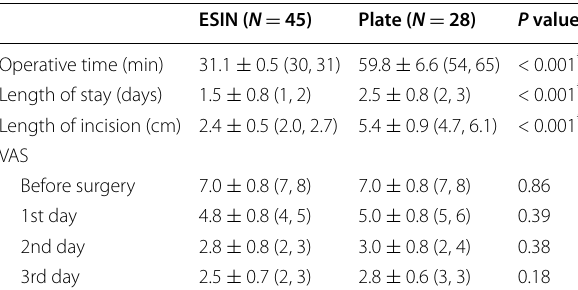
Table 2 Perioperative outcomes of surgery